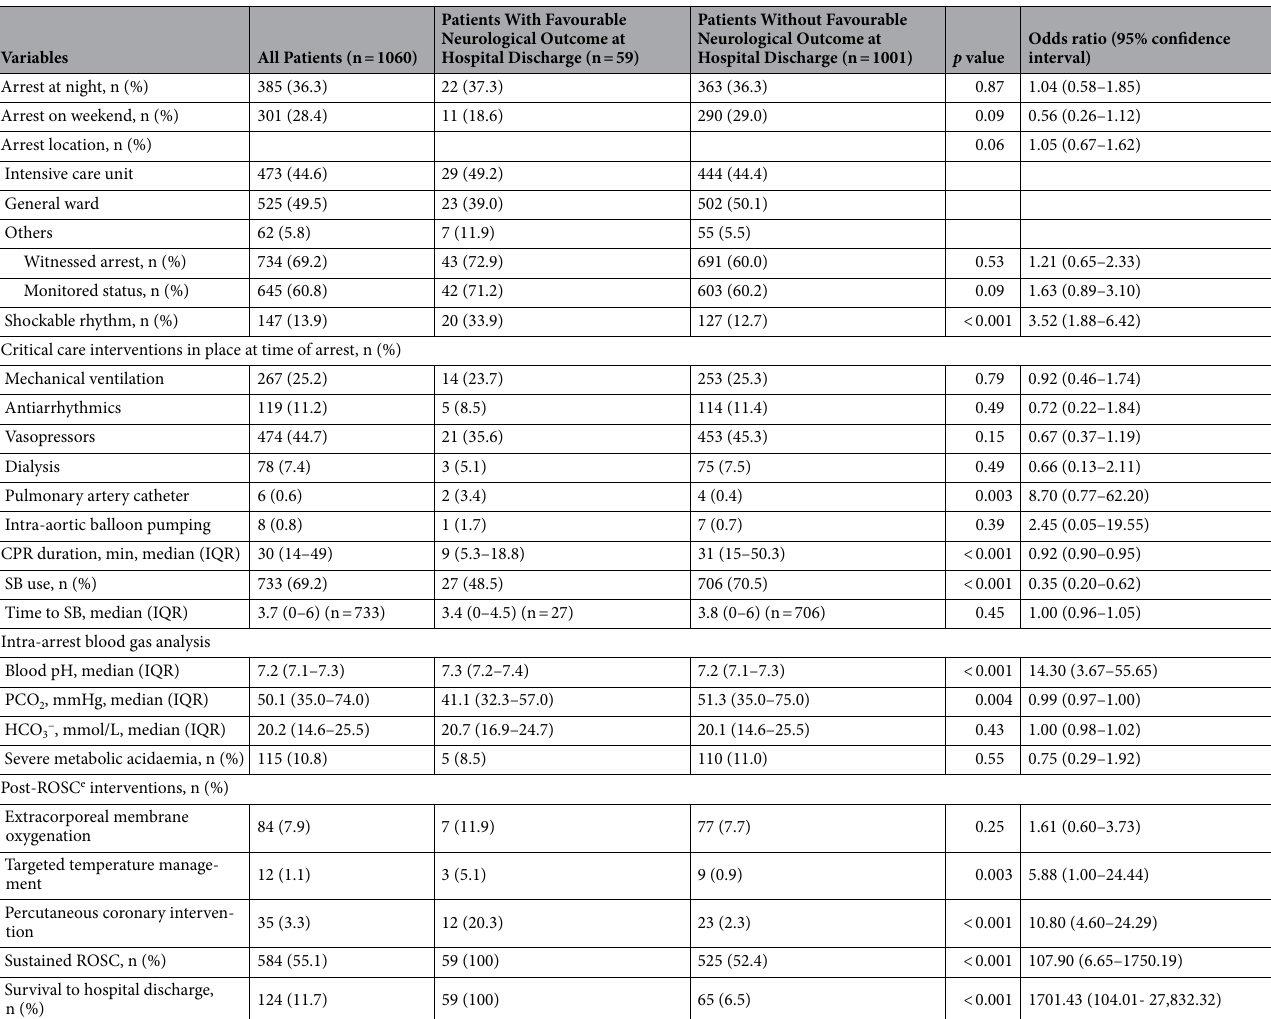
Table 2. Features, Interventions and Outcomes of Cardiac Arrest Events. Abbreviations: CPR, cardiopulmonary resuscitation; IQR, interquartile range; SB, sodium bicarbonate; PCO 2 , partial pressure of carbon dioxide; ROSC, return of spontaneous